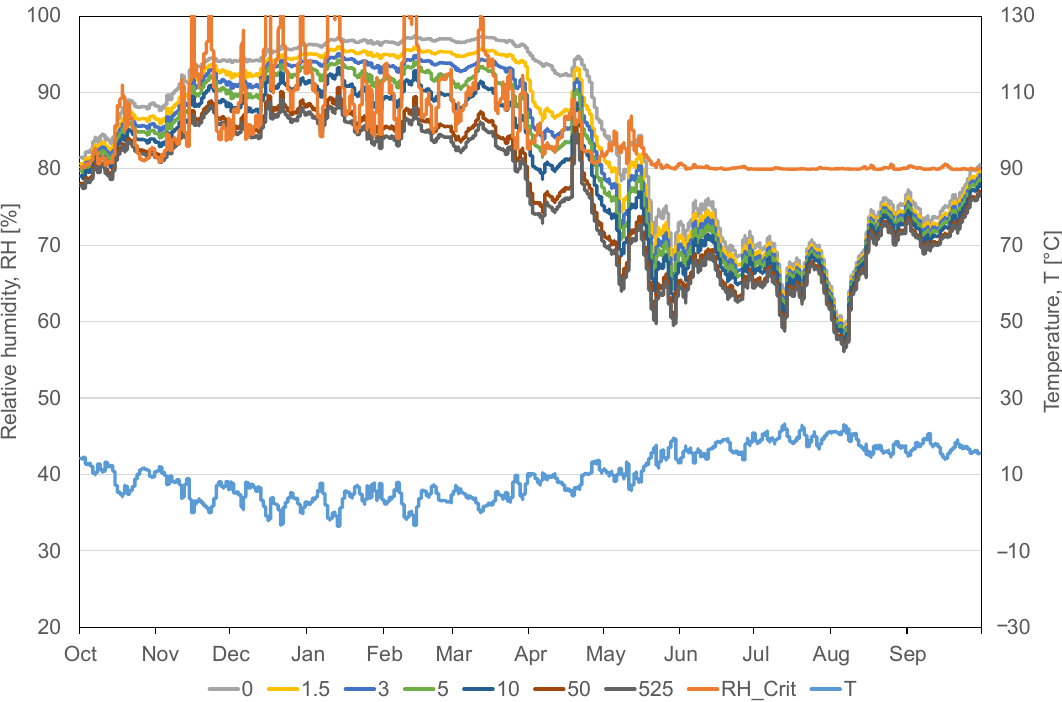
Figure 5. Running average of relative humidity and temperature behind the wind barrier (point A) for internal humidity class 3 and the thermal insulation of cellulose.